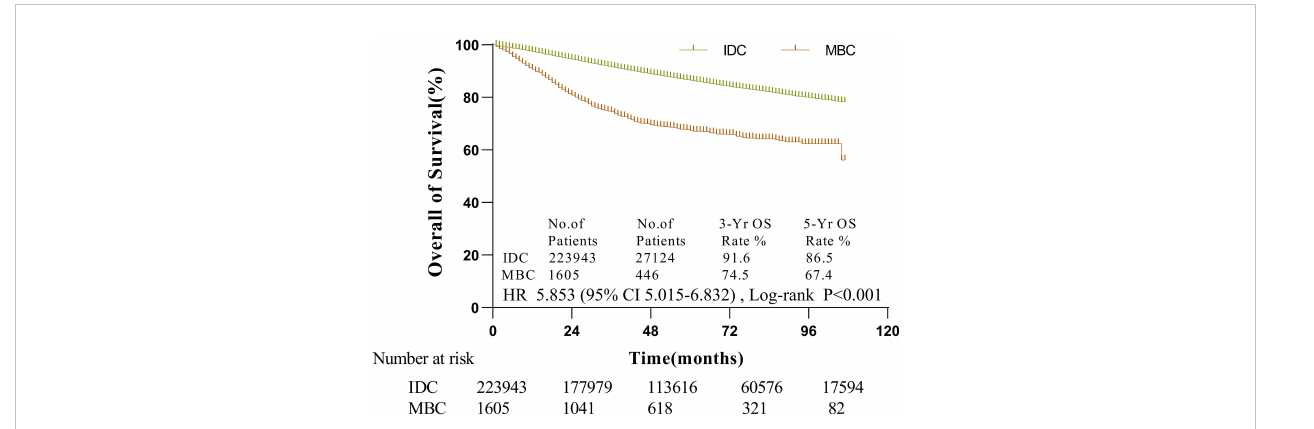
FIGURE 1 The survival of patients with MBC and IDC by Kaplan-Meier analysis. Patients with MBC had worse survival (HR = 5.853, 95% CI, 5.015-6.832,p < 0.001) with 3- and 5-year OS rates of 74.5 and 67.4% vs. 91.6 and 86.5% in IDC patients,